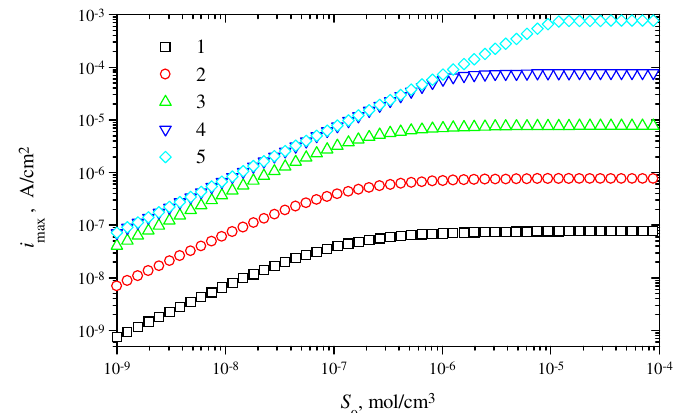
: 10 -9 (1), 10 -8 (2), 10 -7 (3) and 10 -6 max